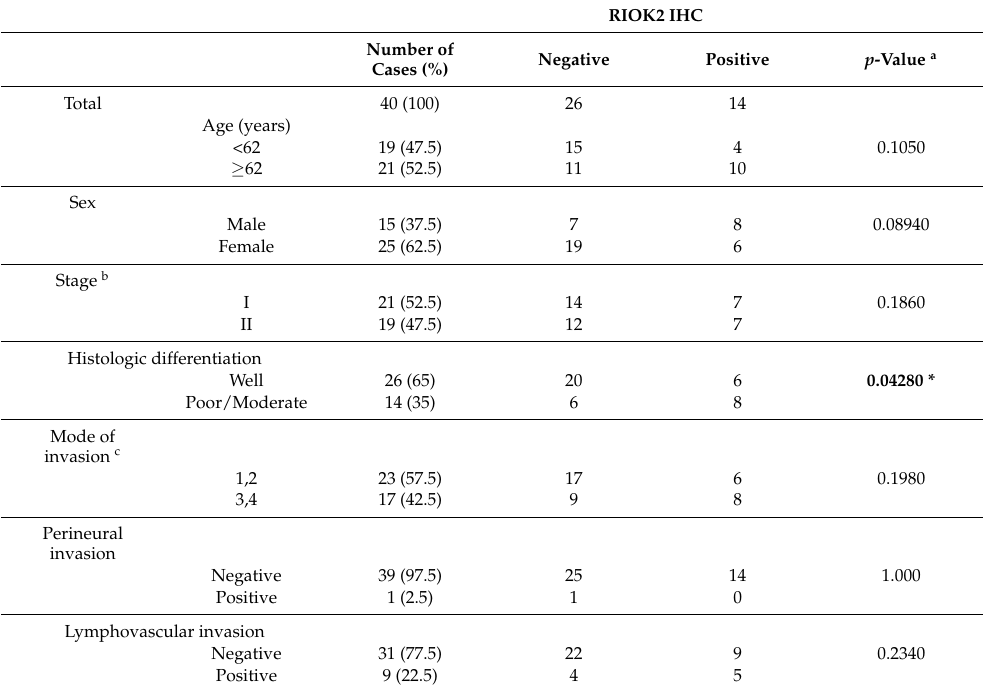
Table 1. Association of RIOK2 with clinicopathologic characteristics in stage I/II TSCC.